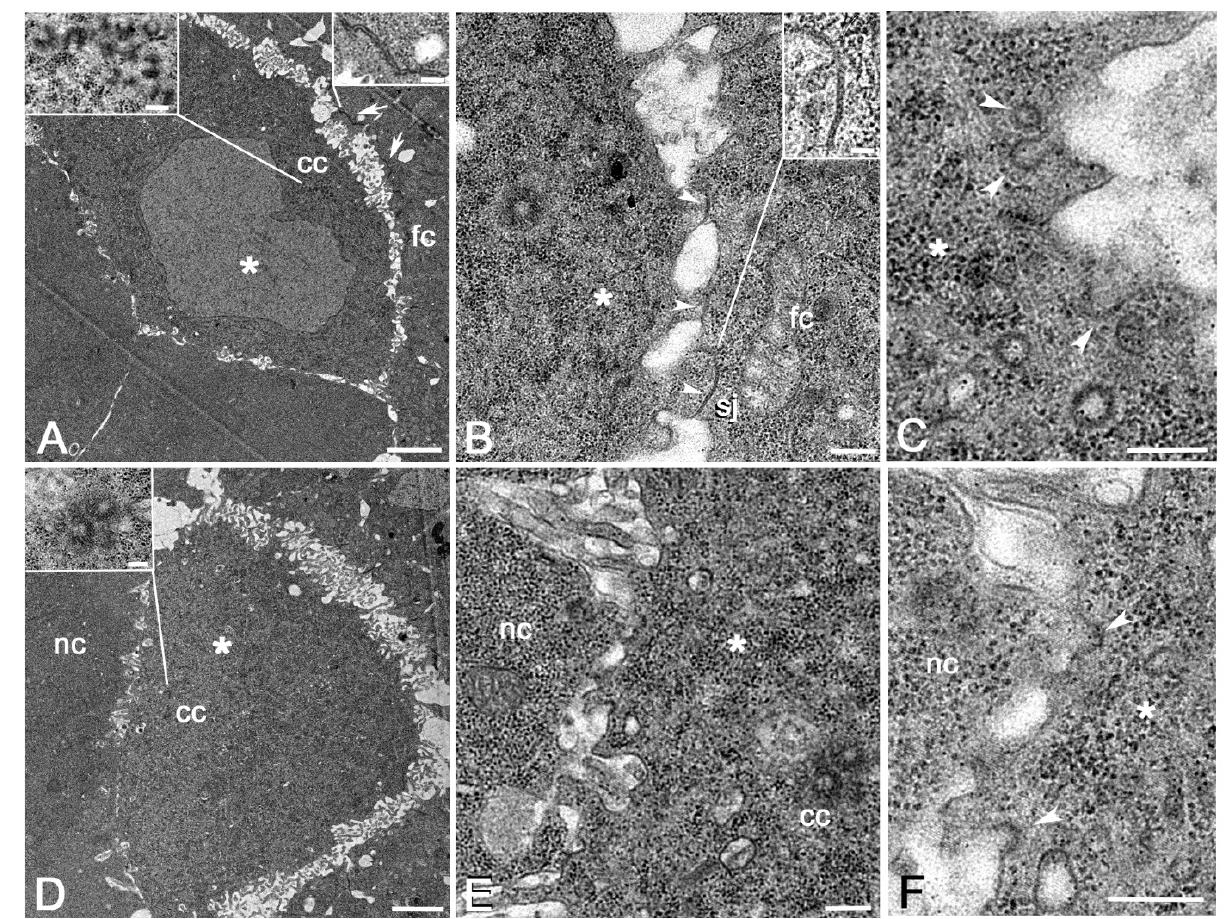
Figure 4. ( A ) Cross section of a stage 7 egg chamber: the space between the posterior region of the oocyte, which still maintains many centrioles, and the facing follicle cells is greatly increased; both the oocyte and the follicle cell membranes elongate in thin elongated protrusions that interdigitate among them; AJs (arrows) are found between adjacent follicle cells. ( B ) Details of some close contacts (arrowheads) between the large protrusions of the oocyte and the follicle cell membranes; a septate junction is also found between the oocyte and the follicle cells. ( C ) Magnification of the oocyte membrane facing the posterior follicle cells: several vesicles (arrowheads) arise from the plasma membrane of the oocyte. ( D ) Cross section of a stage 8 egg chamber: some centrioles are visible in the anterior dorsal region of the oocyte. ( E ) Detail of the anterior dorsal region of the oocyte at the level of the remnant centriole cluster showing thin interdigitating projections of the oocyte and the adjacent nurse cell membranes. ( F ) Magnification of the interface between the oocyte and the nurse cells showing pinocytotic vesicles emerging from the oocyte plasma membrane (arrowheads). as- terisk, oocyte; cc, centrioles; fc, follicle cells; sj, septate junction; nc, nurse cells. Scale bars: ( A , D ), 2 μ m; ( B , E ), 0.2 μ m; ( C , F ), 0.2 μ m; insets, 0.2 μ m.